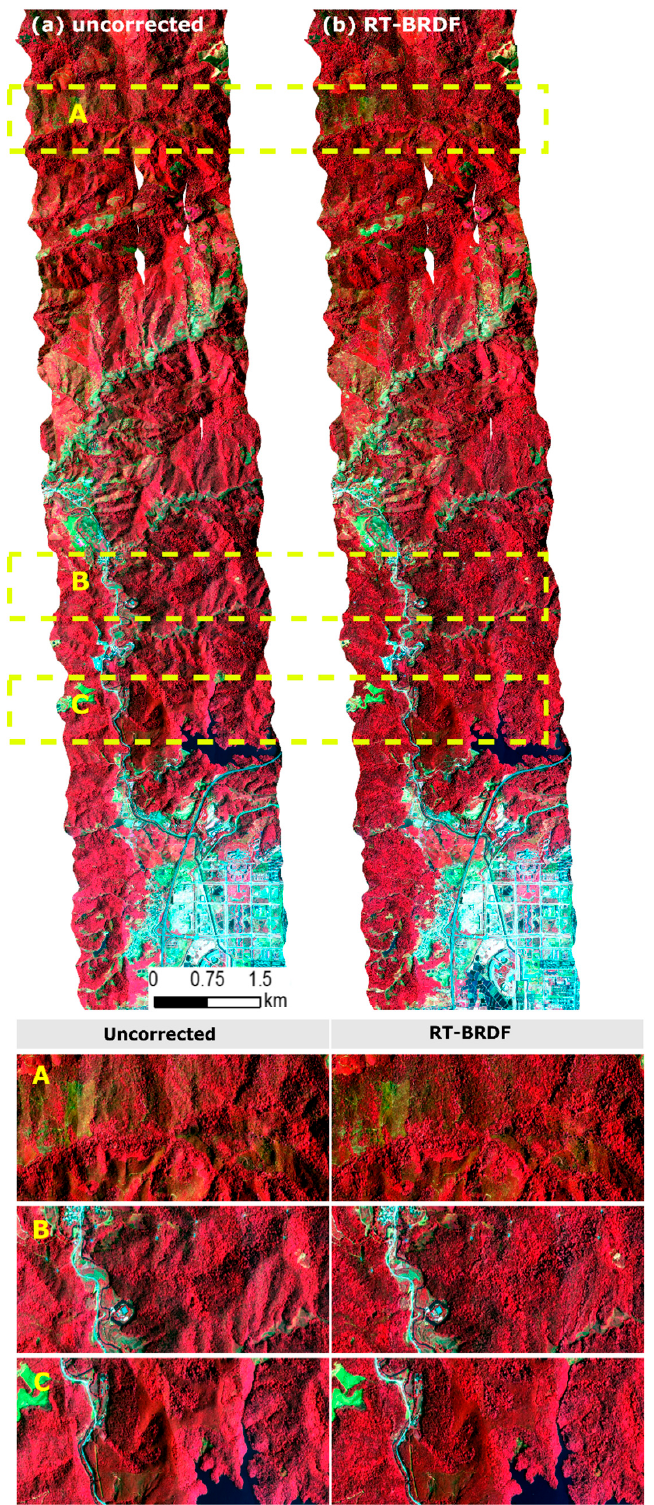
Figure 14. The comparison of uncorrected and RT-BRDF corrected hyperspectral images of the 06 / 04 / 2014 flight mission displayed as false-color composites (i.e., 837.19, 694.91, 543.72 nm bands for the R, G, and B channels, respectively). ( a ) Uncorrected hyperspectral image; ( b ) post-RT-BRDF corrected hyperspectral image. The uncorrected and post-RT-BRDF corrected close-in images are shown for three selected sites (sites A, B, and C).